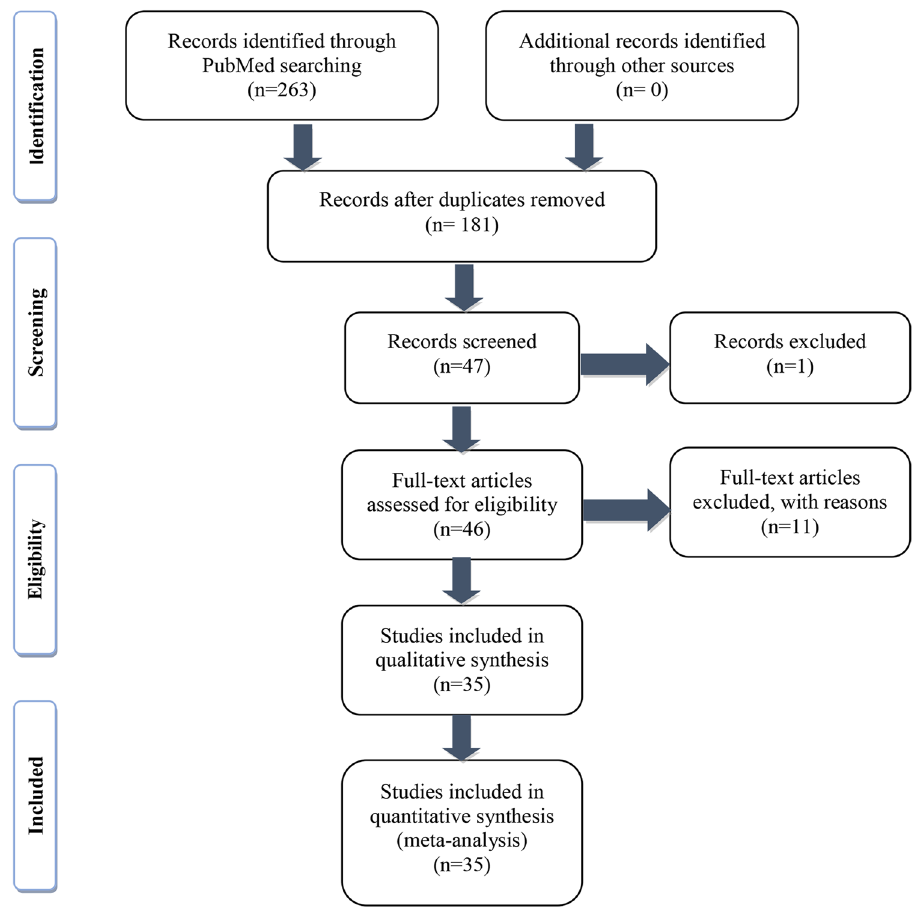
Figure 1: Summary of the article selection